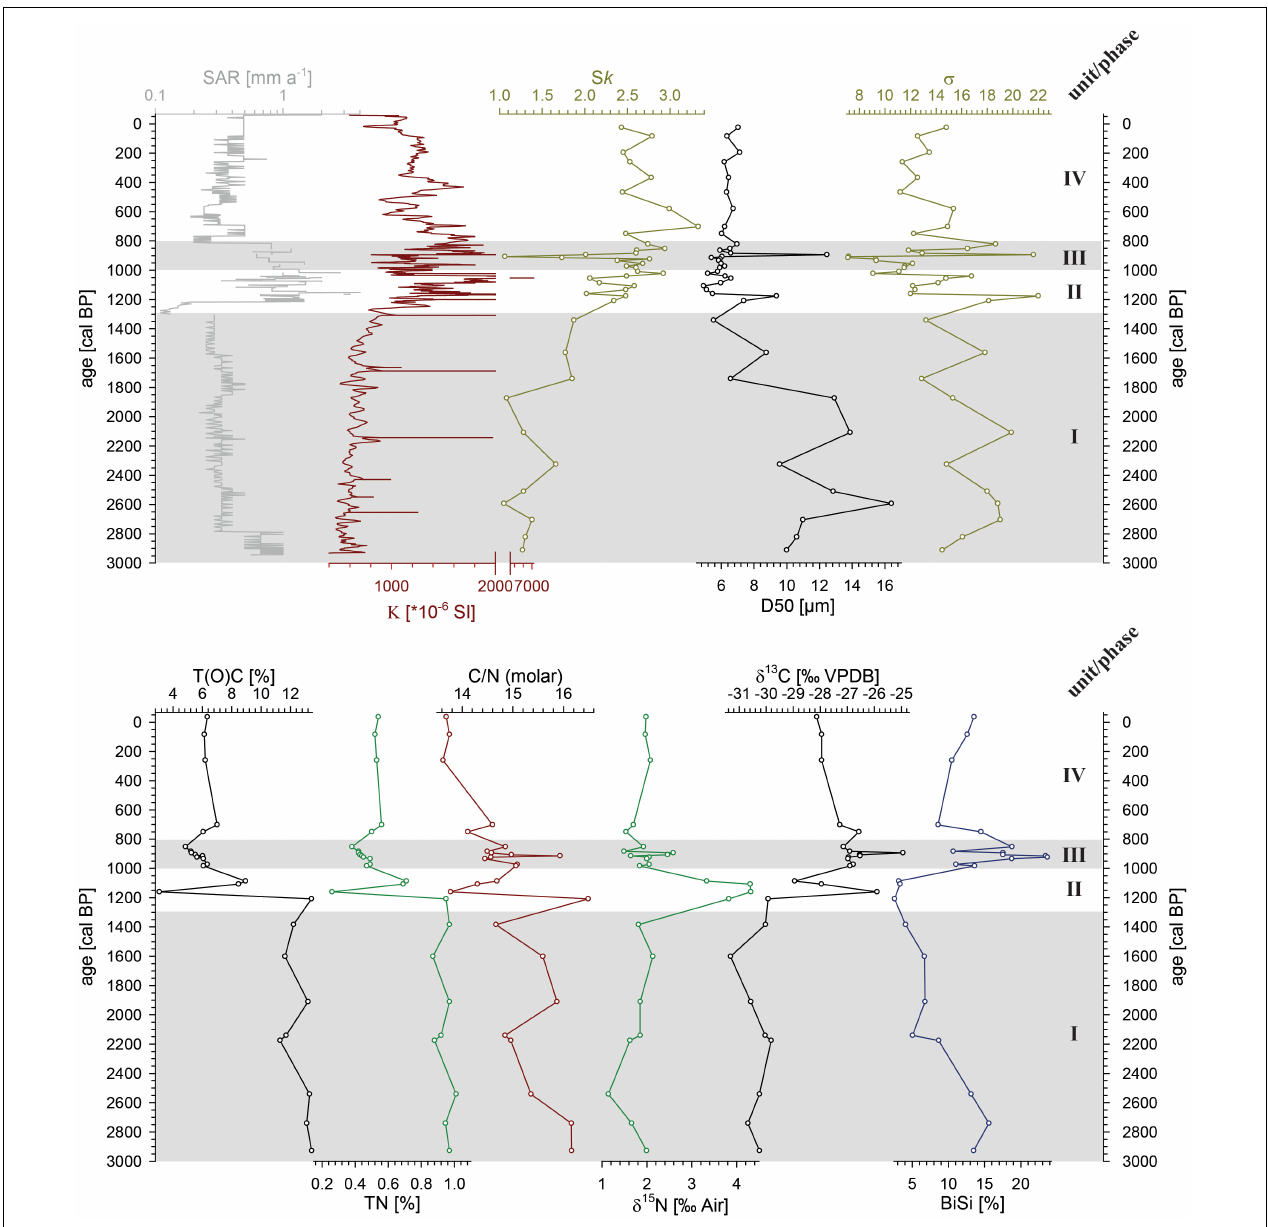
FIGURE 3 | Sedimentological parameters of composite record AMP-16. Upper panel: sediment accumulation rate (SAR), magnetic susceptibility (K), particle size distribution skewness (S k ), particle size median (D50) and particle sorting ( σ ). Lower panel: total (organic) carbon (T(O)C), total nitrogen (TN), molar C/N-ratio, δ 15 N and δ 13 C measured on the bulk organic faction, and biogenic silica content (BiSi). Gray shaded areas demarcate sedimentological units (I to IV).